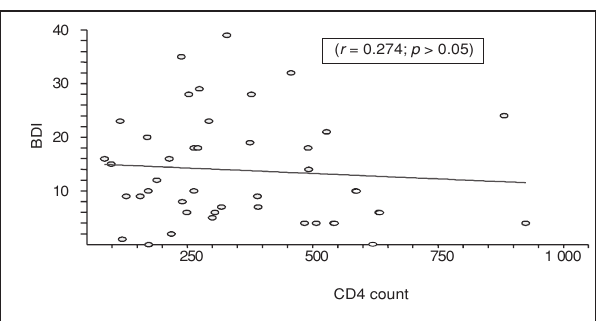
Fig. 1. Correlation between CD4 counts and BDI scores in the study sample.